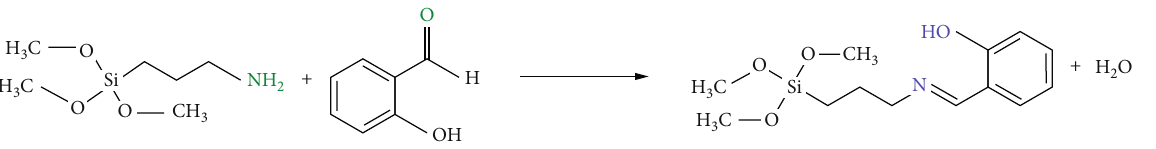
Figure 2: Schematic representation of the HSPTMS formation reaction. Proposed groups responsible for cation adsorption are presented in blue, and the groups that take part in the reaction are shown in